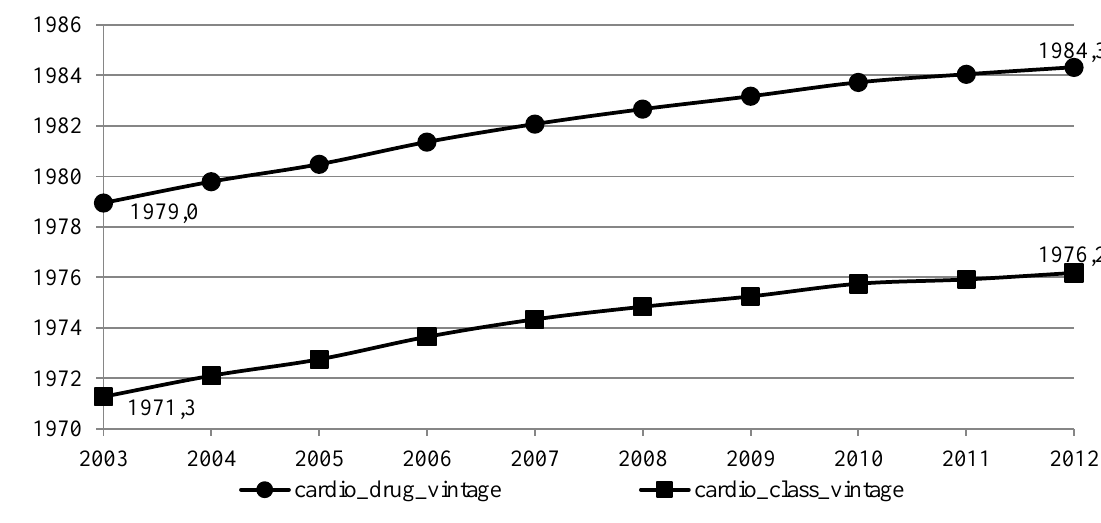
Figure 3: Mean vintage of cardiovascular drugs and drug classes used by elderly (age 66+) CSS enrollees, 2003-2012